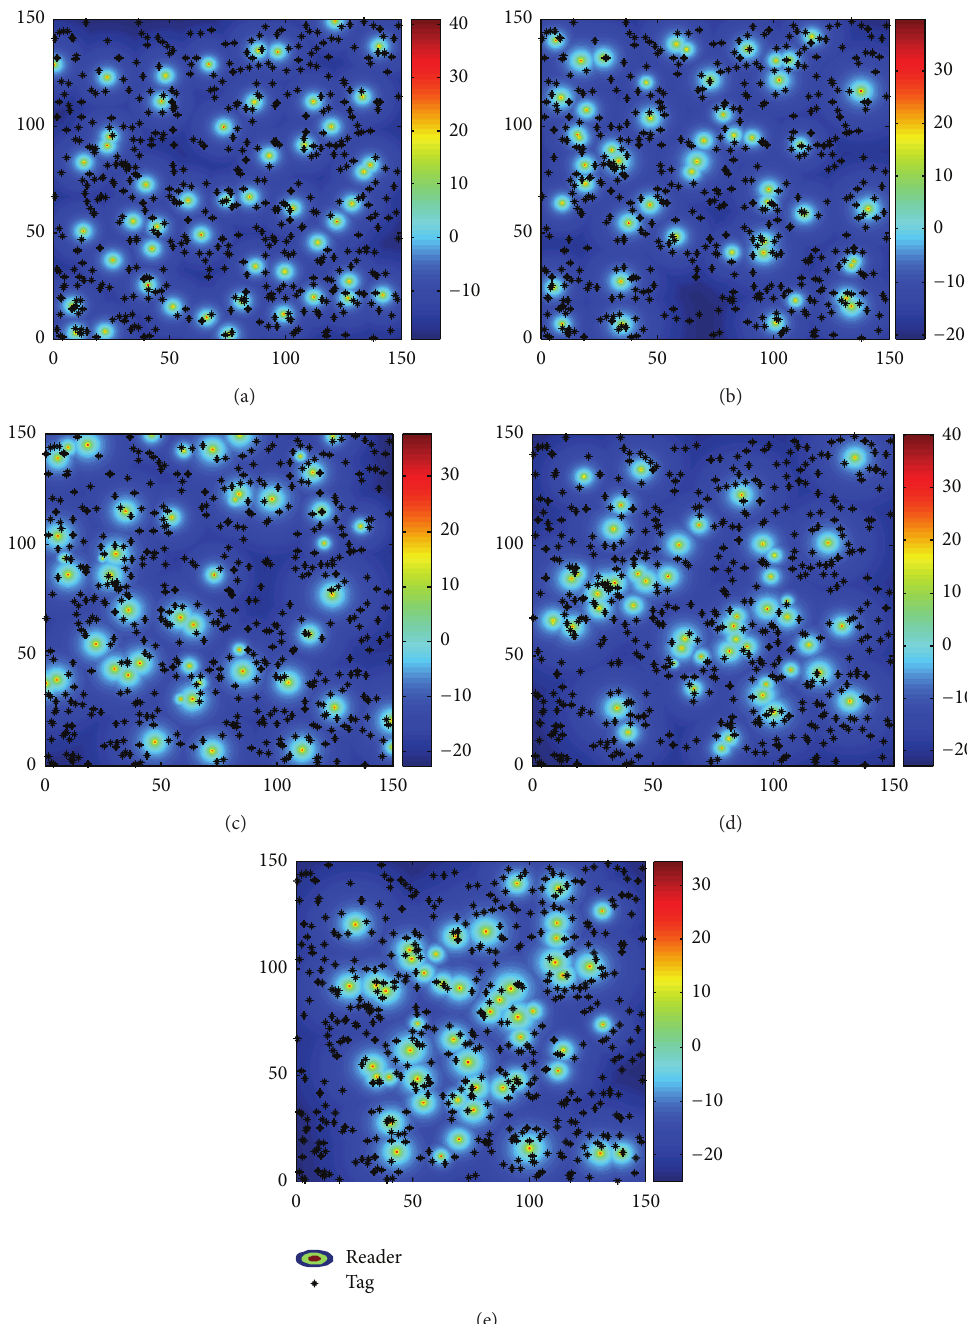
Figure 14: The results of all algorithms on Cd500 with the combined objective function 𝑓 𝑚 . (a) Result of HABC; (b) result of PS 2 O; (c) result of EGA; (d) result of CCEA; (e) result of